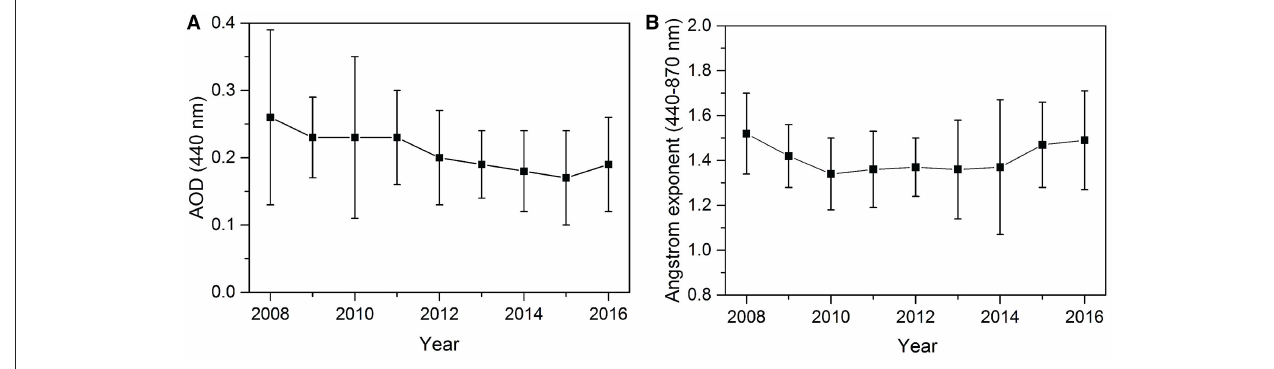
FIGURE 4 | Yearly averaged (A) AOD (440nm) and (B) Ångström exponent (440–870nm) at Kyiv site, data level 2.0.